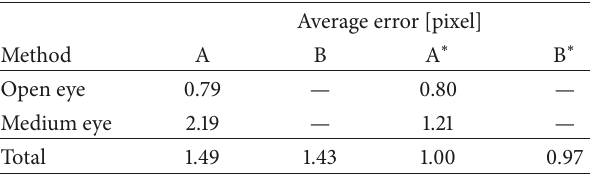
Table 3: Confusion matrix of CNN classification